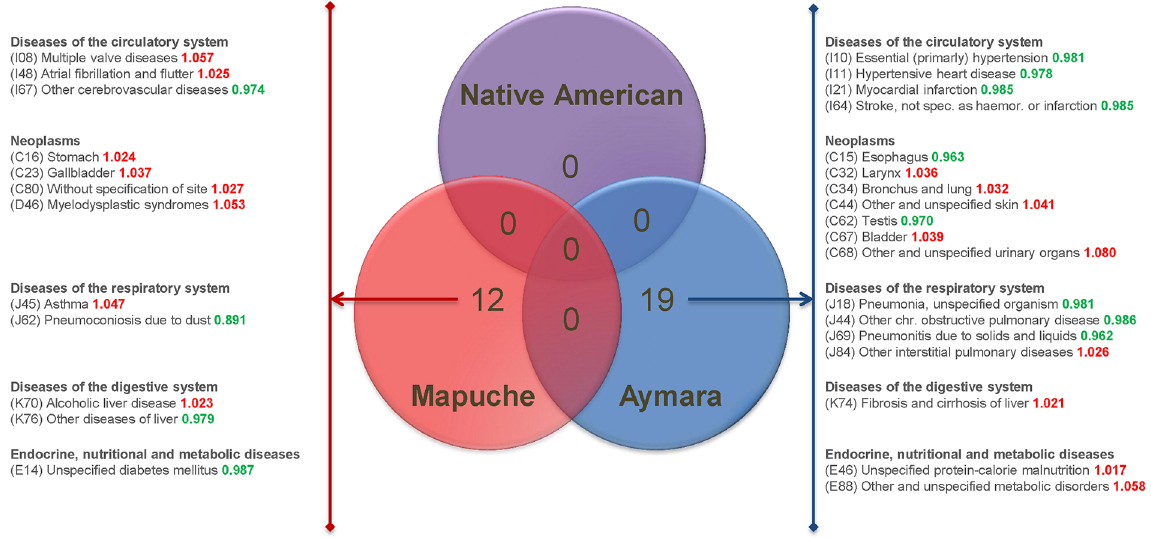
Fig 3. Venn diagram with results from a stepwise forward model selection to identify the ancestrycomponents showing the most significant associations with disease-specific mortality rates. Mapucheancestry (reddish)showedthe most significant associations with mortality rates due to 12 ICD10-disease categories and the Aymara component(in blue) was selectedfor 19